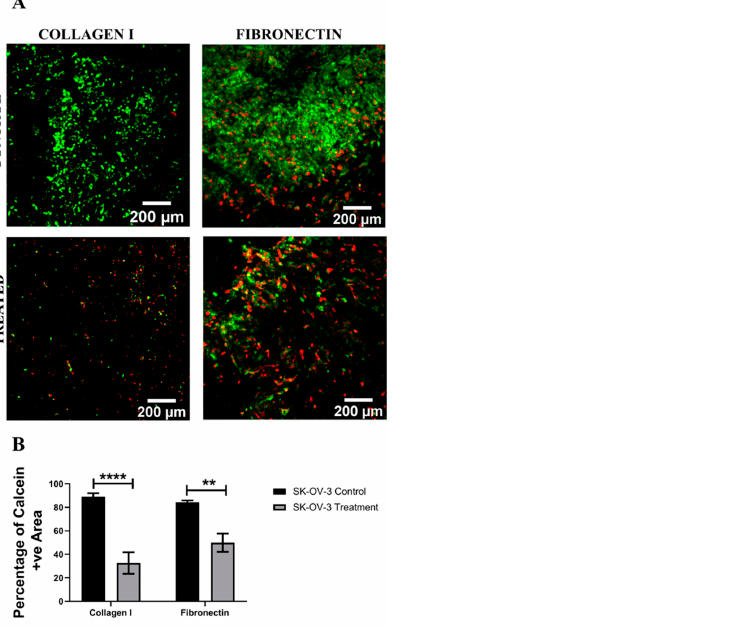
Figure 8. Effect of the chemotherapeutic Cisplatin on the viability of SK-OV-3 EOC cells grown in PU scaffolds of various protein coatings, 24 h post-treatment ( A ): Representative images for live– dead (green–red) staining in collagen I- and fibronectin-coated treated and untreated (control) SK-OV-3 polymeric scaffolds. ( B ) Image analysis-based quantification of live (green) image areas for SK-OV-3 cells grown in collagen I and fibronectin coated polymeric scaffolds. Scale bar = 200 μ m. Quantitative data represent mean ± SEM for multiple images ( ≥ 3) and multiple scaffolds ( ≥ 3). ** p ≤ 0.01, **** p ≤ 0.0001 .